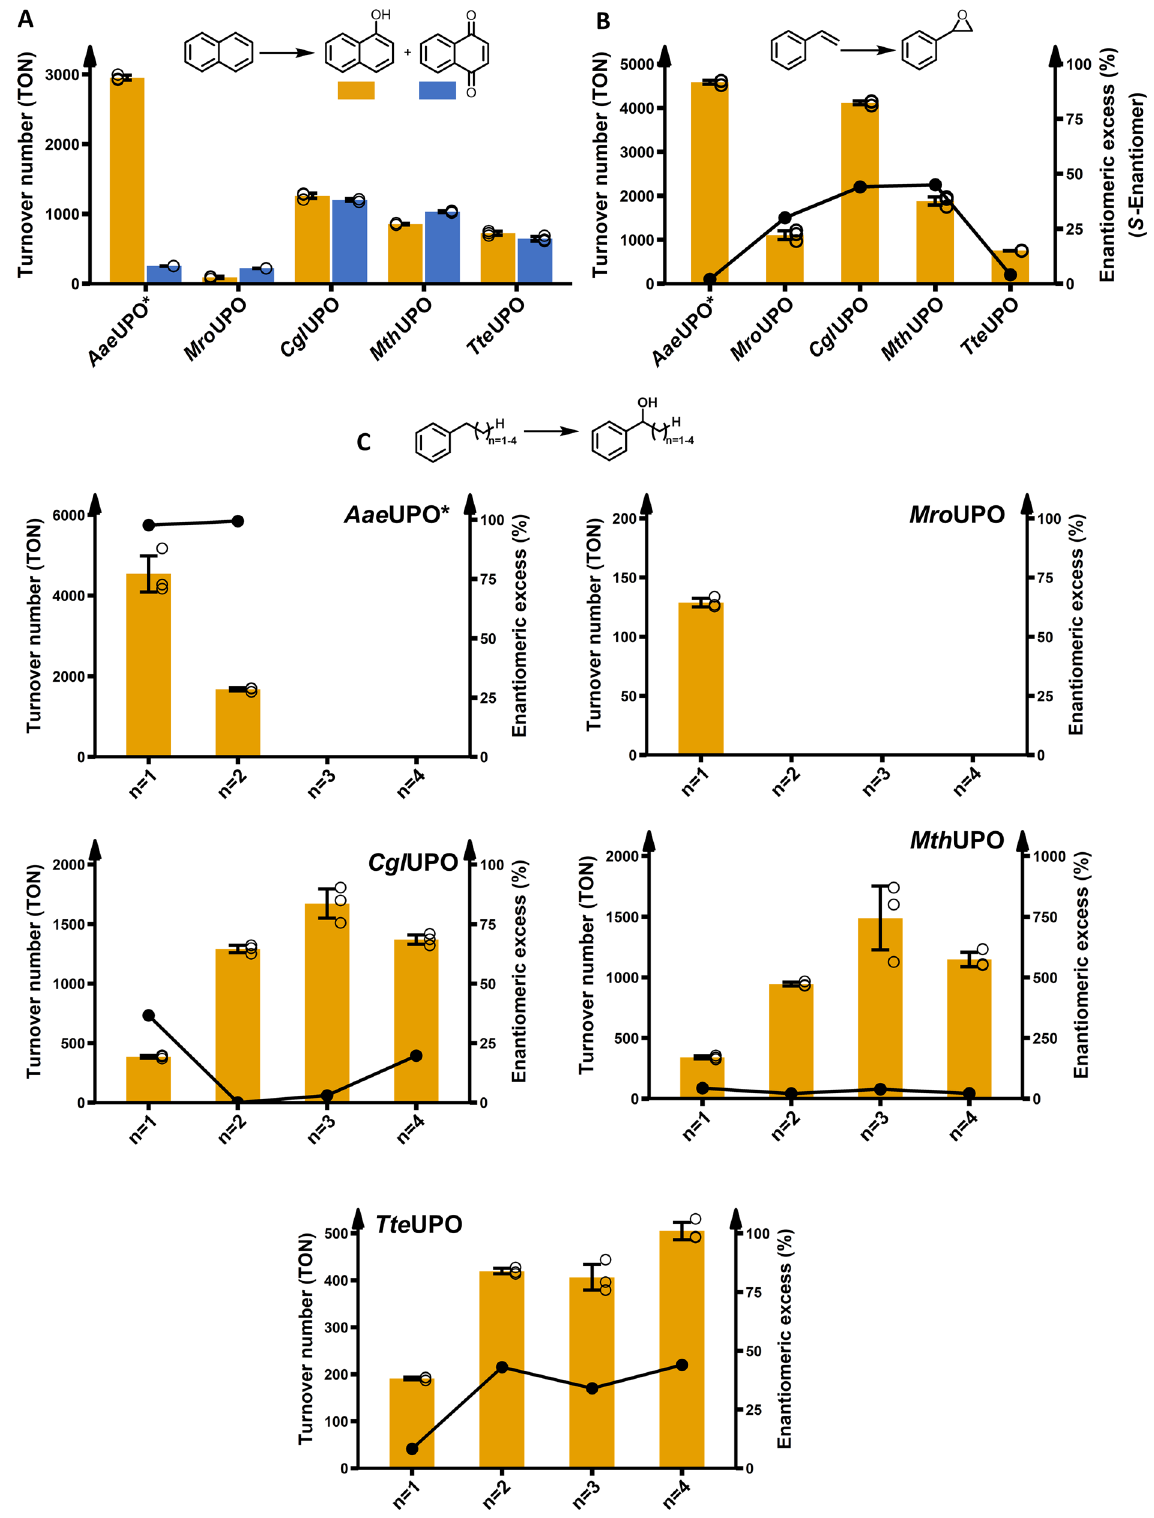
Fig. 3 Enzymatic activity assessment of the peroxygenases regarding aromatic hydroxylation, epoxidation and sp 3 -carbon hydroxylation. All reactions were performed for 1 h using 1 mM of substrate. Bar charts display the obtained turnover numbers (TON) within one hour. The lines correspond to the enantiomeric excess %. Data are mean ± s.d. measurements derived from biological triplicates with individual data points shown as circles. See supplementary information for further details. A Conversion of naphthalene to naphthol and 1,4-naphthoquinone. B Conversion of styrene to styrene oxide. C A homologous row of phenylethane, phenylpropane, phenylbutane and phenylpentane hydroxylation, respectively, focusing on hydroxylation of the benzylic carbon. The alcohol enantiomer is indicated by an (R) or (S). The exact enantiomer for phenylpentane was not determined. See Supplementary Fig. 17 for occurrence of side-products. For Mro UPO catalysed conversion of phenylethane no enantioselectivity could be determined.